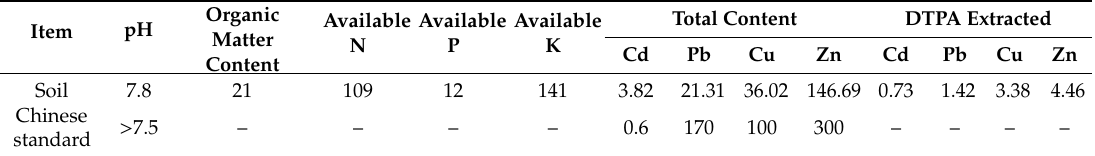
Table 1. Soil characteristics and Chinese soil environmental quality standards (total concentration in mg · kg − 1